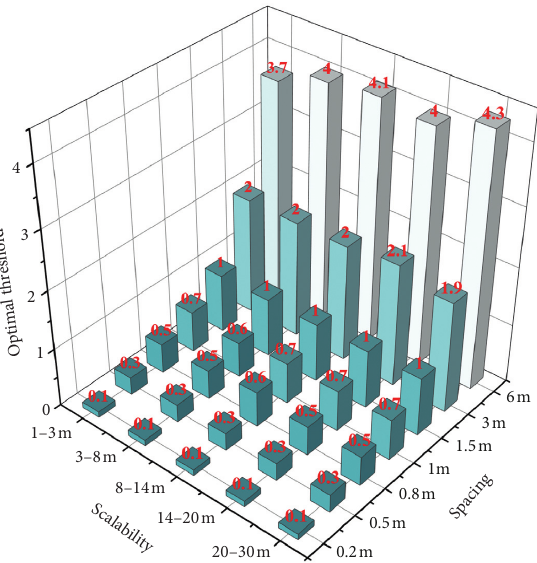
Figure 6: Optimal threshold in different models.